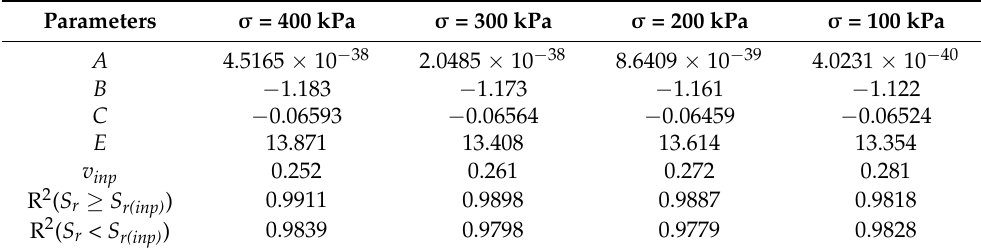
Table 3. Fitting parameters of the predictive model.